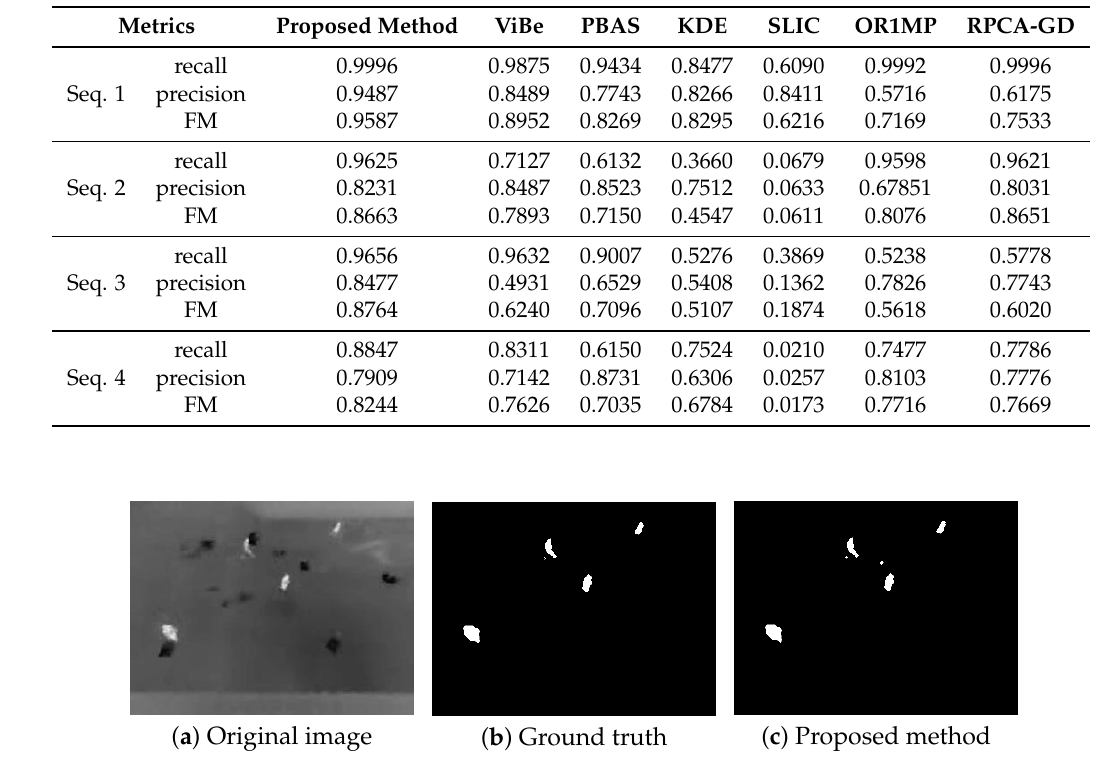
Table 5. Average evaluation metrics of different methods.